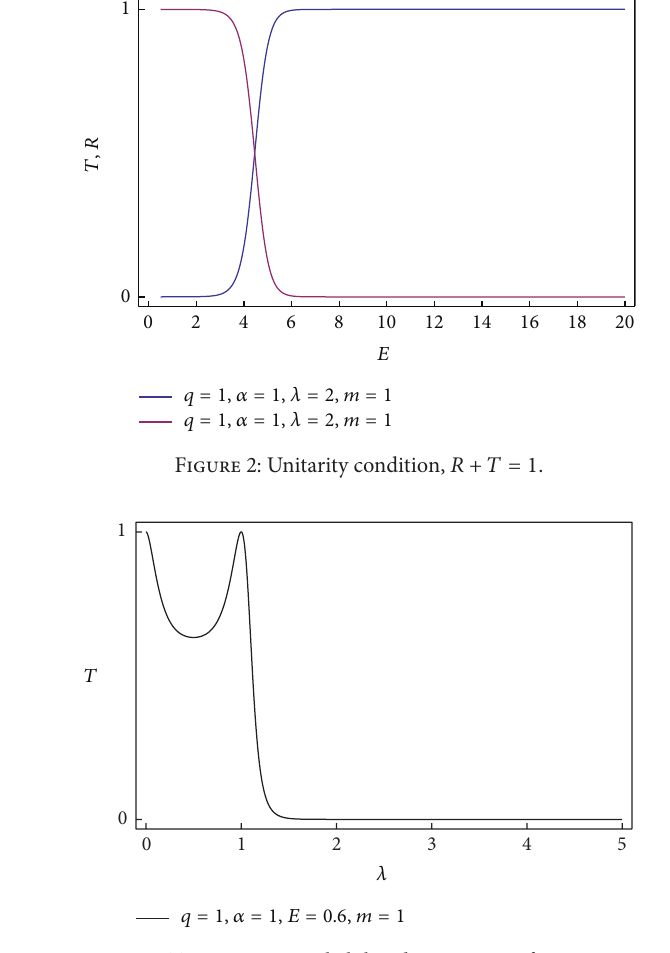
Figure 3: Transmission probability density versus 𝜆 parameter. Table 1: Table for some definitions used in calculations of 𝑇 and 𝑅